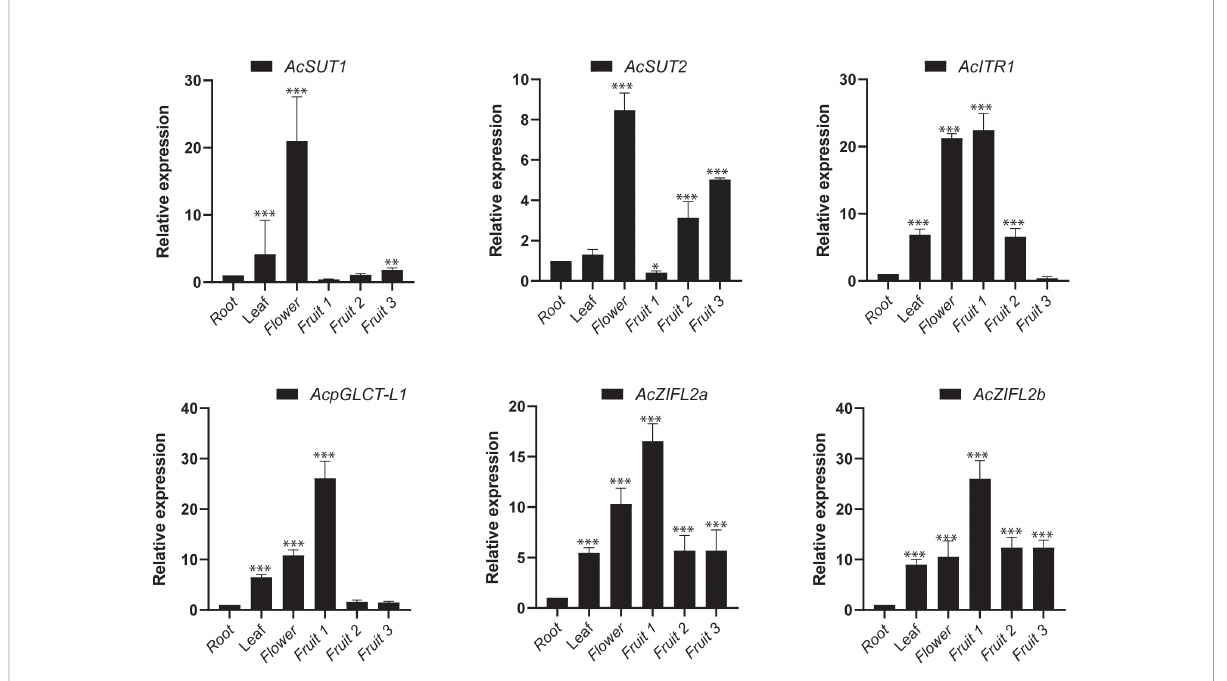
FIGURE 10 The relative expression levels of 6 sugar transporter genes of pineapple veri fi ed by quantitative real-time PCR (RT-qPCR). Gene expression is represented in fold change of expression calculated against pineapple EF1 a by the Livak method (2 − DD CT ). Vertical bars represent the mean± SE of three biological replicate assays. The asterisks represent statistically signi fi cant values (*p < 0.05, **p < 0.01 and *** p <